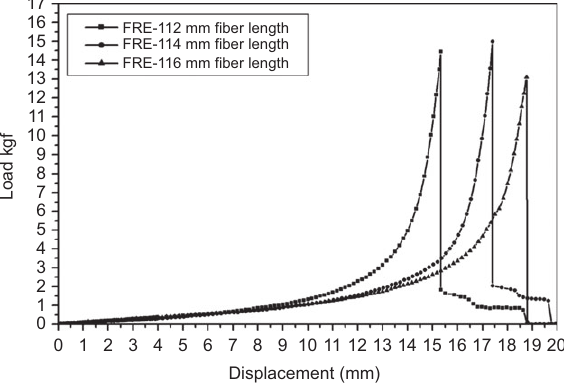
Figure 7 Load-displacement curve of the FRE specimens with different fiber lengths.